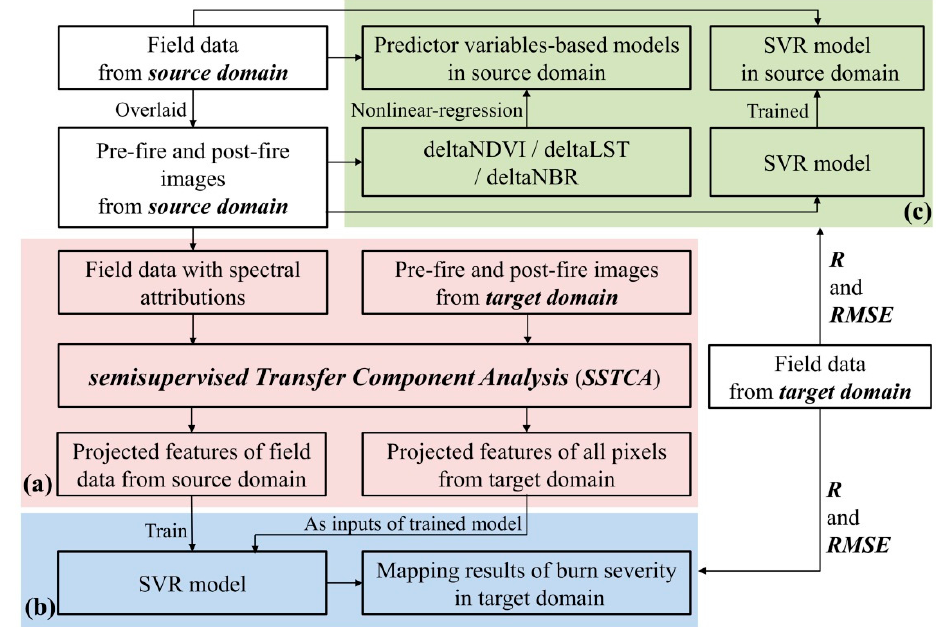
Figure 1. The flowchart of methodology: ( a ) domain adaptation; ( b ) burn severity mapping; and ( c ) performance validation and comparisons.